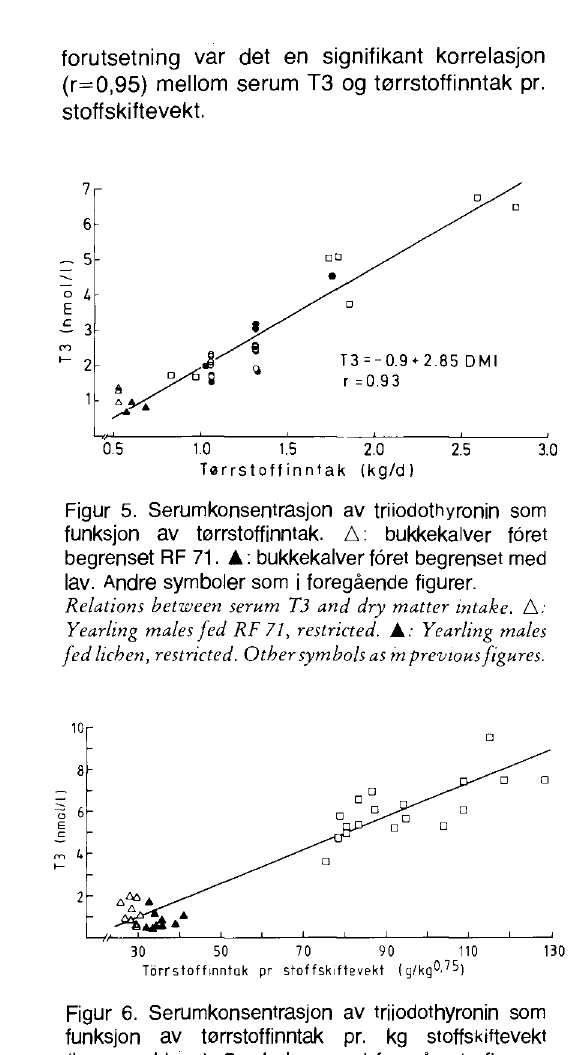
Figur 6. Serumkonsentrasjon av triiodothyronin som funksjon av tørrstoffinntak pr. kg stoffskiftevekt (kroppsvekt 0,75). Symboler som i foregående figurer. Relation between serum T3 and dry matter intake per kg metabolic weight (body weight 07s). Symbols as in previous